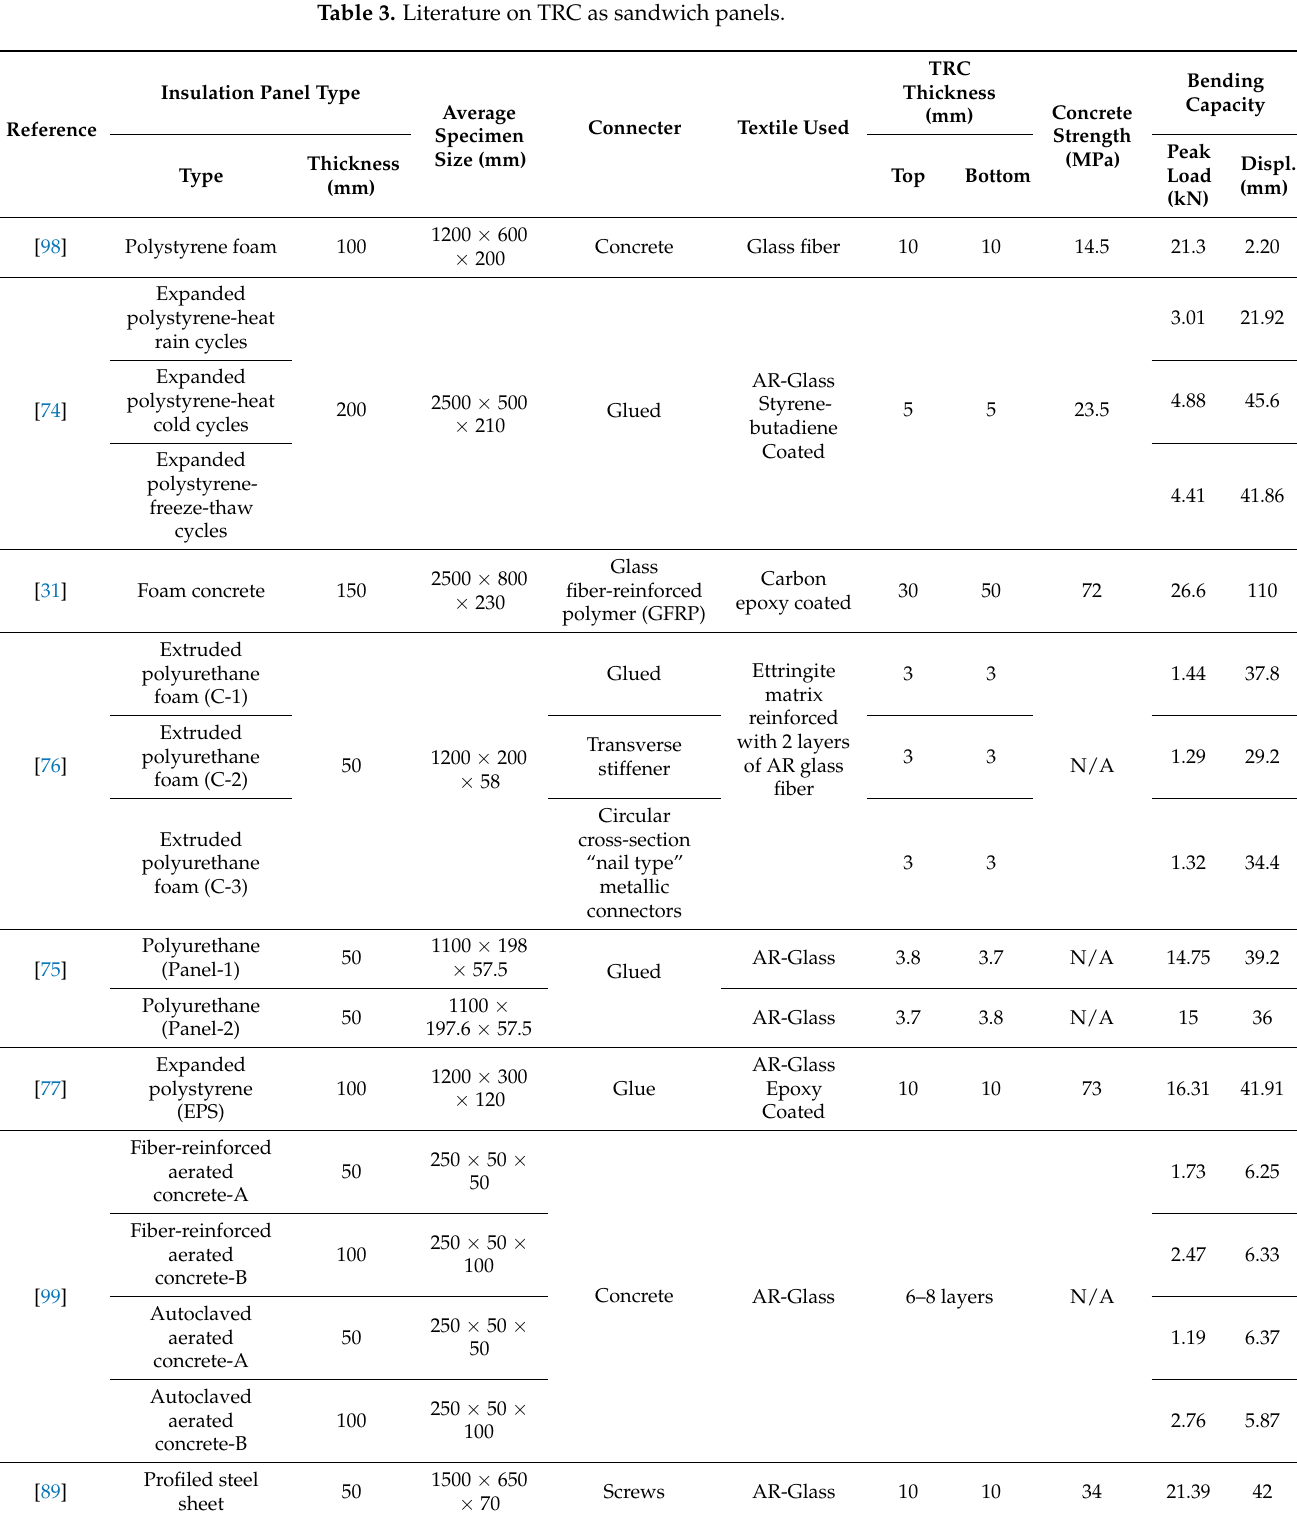
Table 3. Literature on TRC as sandwich